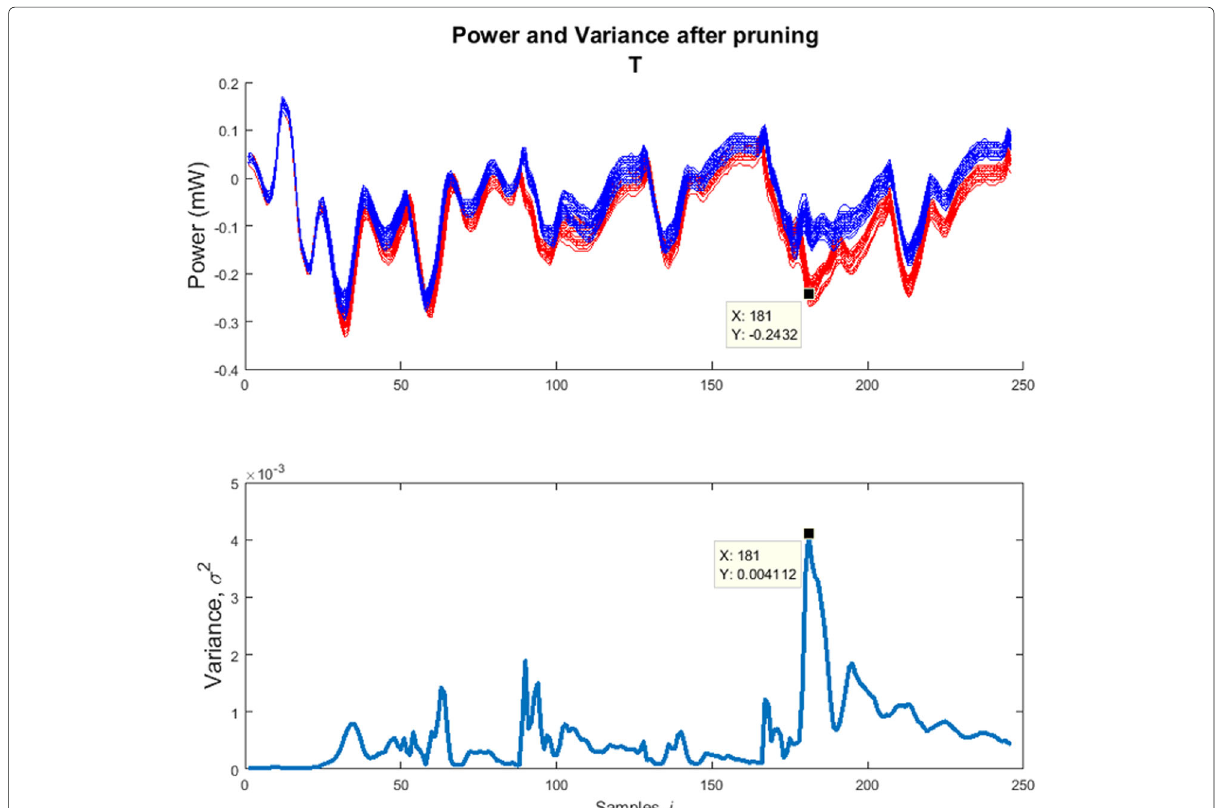
Fig. 11 Power dissipation in key transfer. The power dissipation varies with respect to the key being transferred to the AES